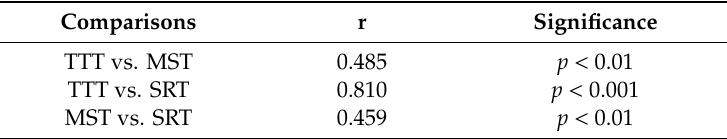
Table 3. Pearson correlations among the flexibility tests.